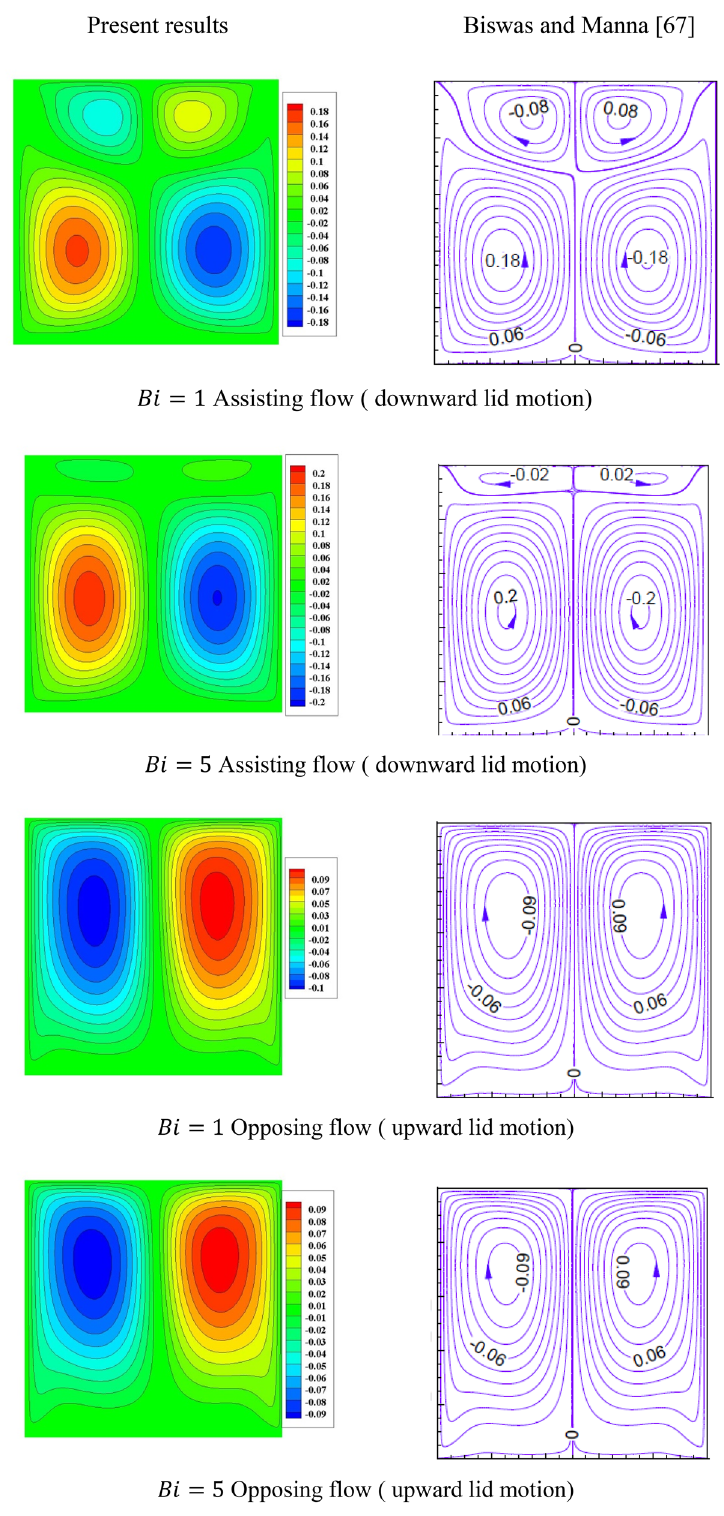
Figure 2. comparison of the streamlines for the different values of Biot number at Re = 200, Gr = 10 5 , Ma = 1000